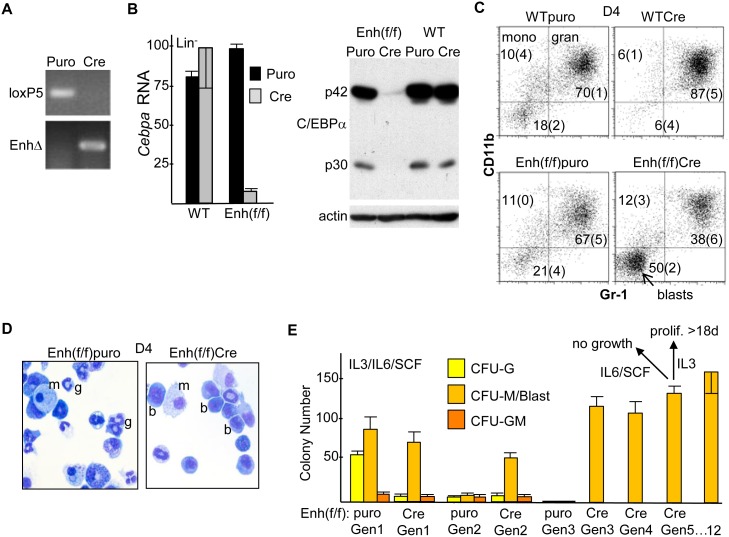
Effect of in vitro Enhancer Deletion on Cebpa Expression and Myelopoiesis.A) Mononuclear marrow cells from WT or Enh(f/f) mice were placed in IMDM/FBS with IL-3, IL-6 and SCF for 24 hr, transduced with pBabePuro (Puro) or pBabePuro-Cre (Cre) for 48 hr, puromycin selected for an additional 48 hr, and finally lineage-depleted. Genomic DNA was then subjected to PCR using the loxP5 or EnhΔ primer pairs followed by agarose gel electrophoresis and visualization by ethidium bromide staining. B) Total cellular RNAs were analyzed for Cebpa and large ribosomal subunit mS16 mRNA expression. Cebpa RNA expression, normalized using mS16 expression and set to 100 for WT marrow transduced with Cre, is shown (left, mean and SD from 3 determinations). Total cellular proteins isolated from the same groups of Lin- cells were subjected to Western blotting for C/EBPα and β-actin; locations of the p42 and p30 C/EBPα alternative translation variants are indicated (right). C) Lin- cells were placed in liquid culture with IMDM/FBS, IL-3, IL-6, and SCF and analyzed for surface CD11b and Gr-1 expression on day 4 (D4; mean and SD from three determinations). D) The morphology of Puro- or Cre-transduced Enh(f/f) cells from these cultures was assessed on D4 by Wright’s Giemsa staining; g—granulocyte; m—monocyte; b—blast. E) Lin- cells were cultured similarly in methylcellulose at 1E3 cell/mL, and myeloid CFUs were enumerated 7–8 days later (Gen1). CFU cells were then collected, washed with PBS, replated at 1E3 cells/mL, and analyzed similarly each 7 days (Gen 2 to Gen 12). In addition, a proportion of Gen5 cells were evaluated for their ability to proliferate in liquid culture in IMDM/FBS with IL-6/SCF or IL-3.